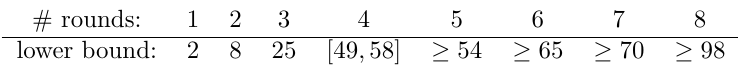
Table 2: Lower bounds for the weight of differential trails in Subterranean for different number of